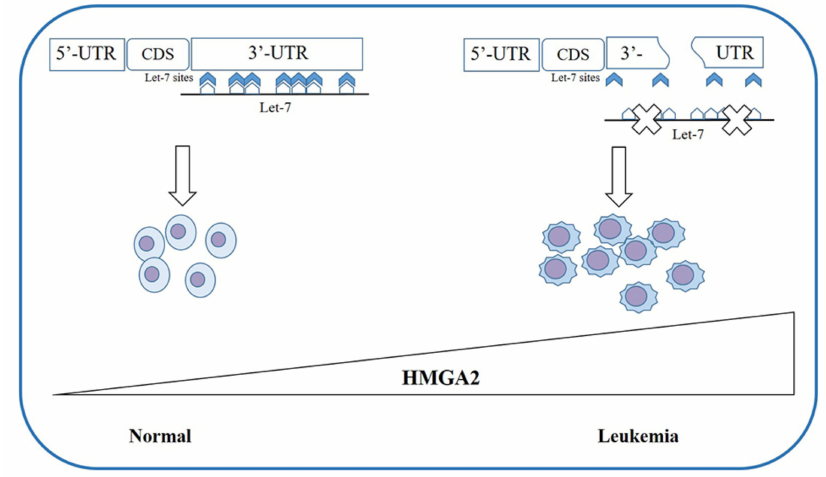
Figure 2. Di ff erent expression of HMGA2 in hematological diseases: Following the truncation of the 3 (cid:48) -UTR, the binding sites for let-7 are lost and the negative regulation of miRNA on the expression of HMGA2 no longer occurs. Overexpression of HMGA2 leads to a clonal growth advantage of the hematopoietic cell, as observed in MPN, PNH, and MDS patients. HMGA2-High mobility group AT-Hook 2; 3 (cid:48) -UTR-3 (cid:48) -Untranslated Region; MPN-Myeloproliferative neoplasms; PNH-paroxysmal nocturnal hemoglobinuria; MDS-myelodyslastic